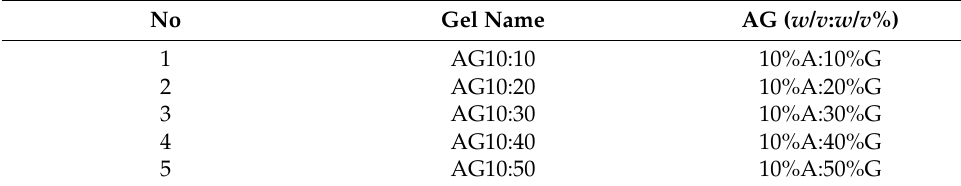
Table 1. The proposed concentrations of AG gels.